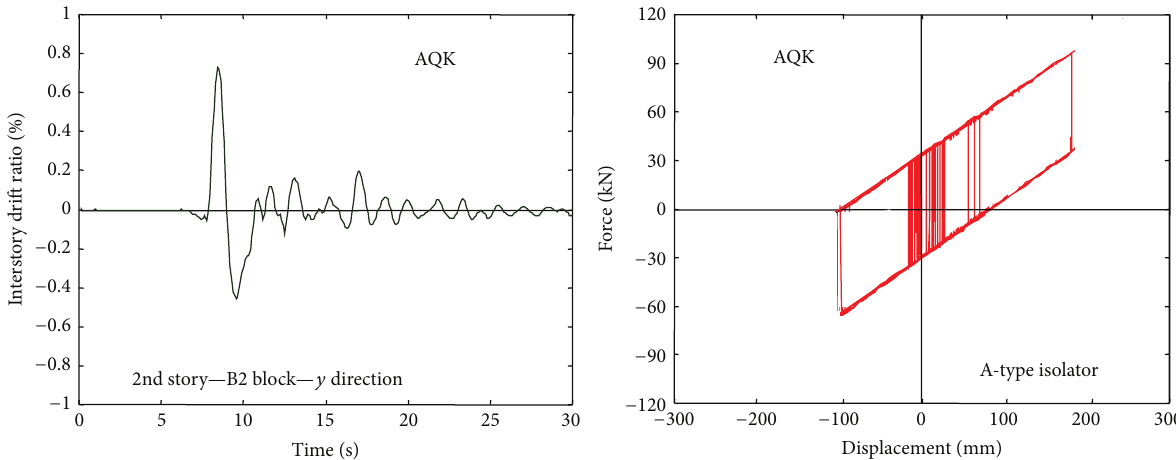
Figure 12: Second interstory drift ratio time-histories for B2 block and response cycles of most stressed DFP isolator obtained in 𝑦 direction from the NS AQK input accelerogram.